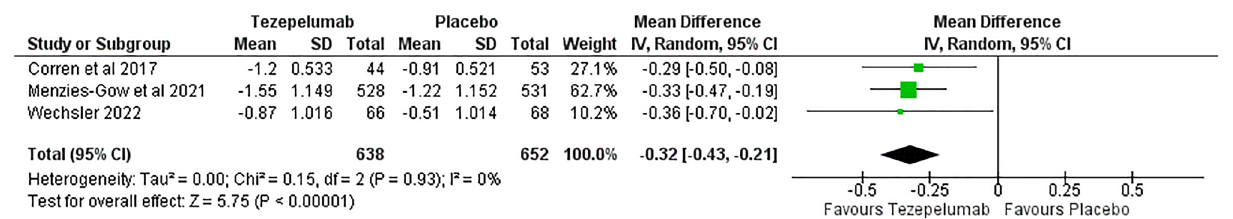
Figure 6. Change from baseline in Asthma Control Questionnaire-6 (ACQ-6) Score.